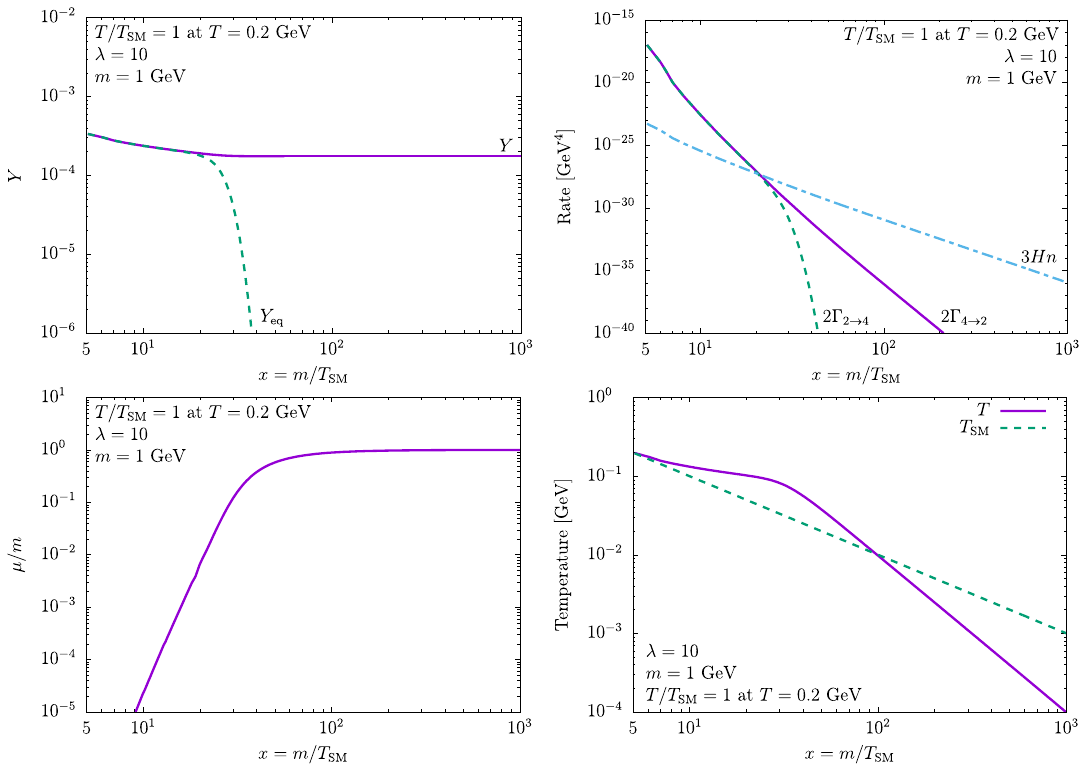
Figure 3 . Thermodynamic quantities as a function of x for non-relativistic